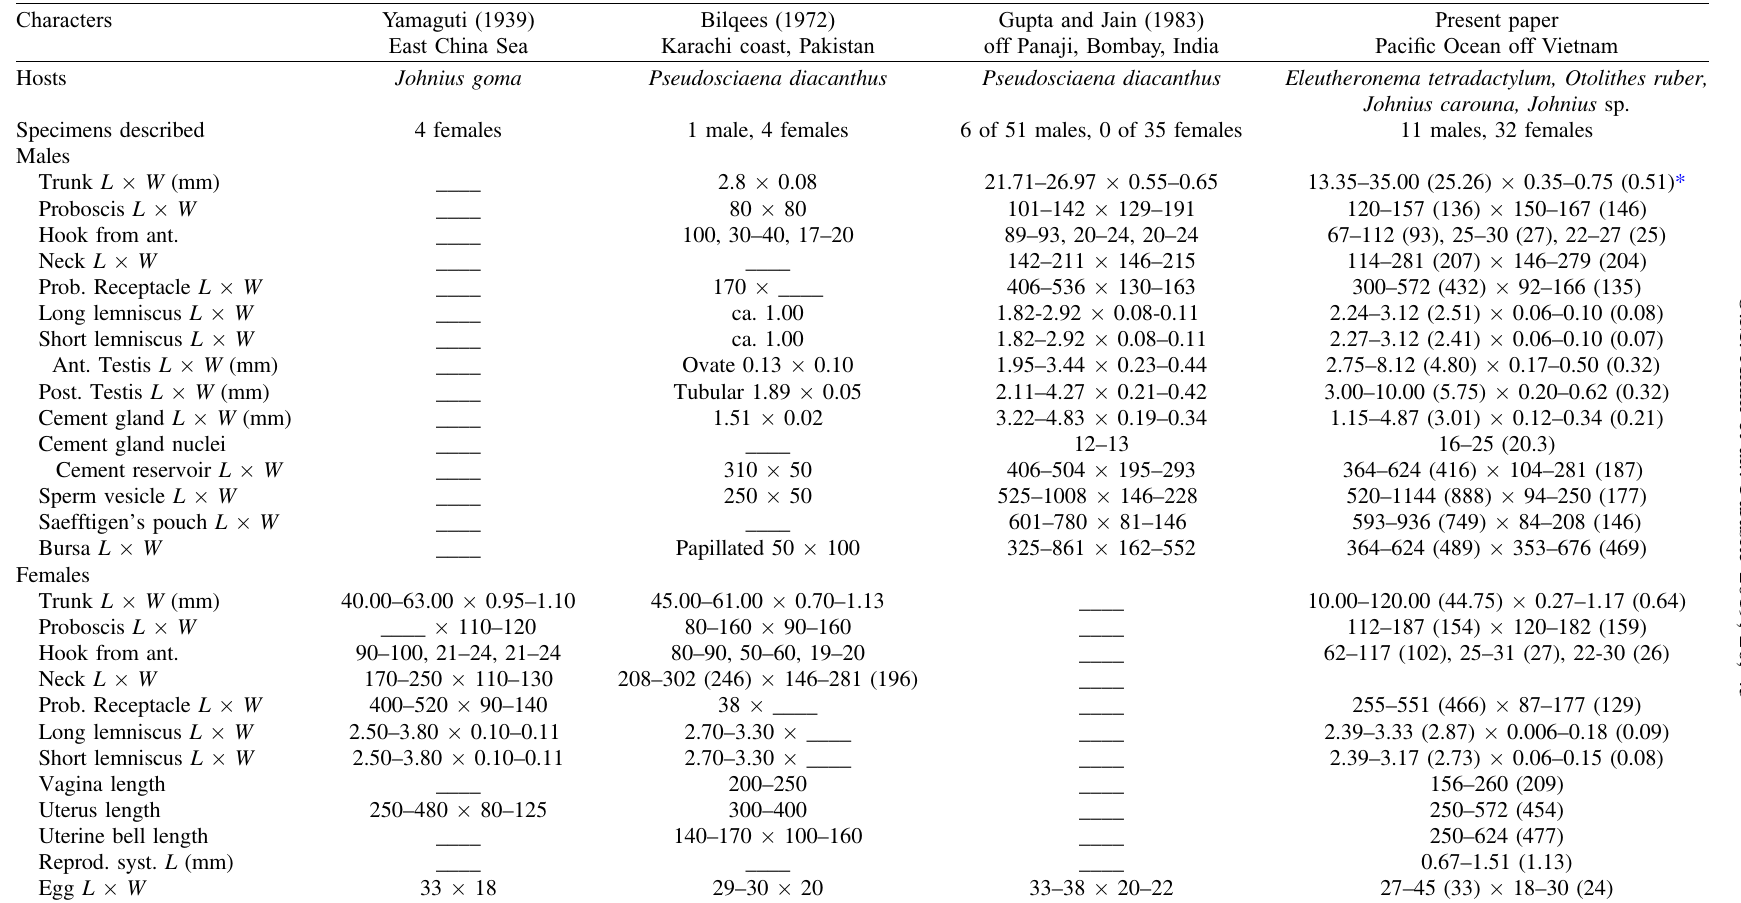
Table 2. Morphometric comparisons between our specimens of Neoechinorhyhchus johnii from Vietnam and those reported in previous descriptions from Japan and the Indian Ocean.